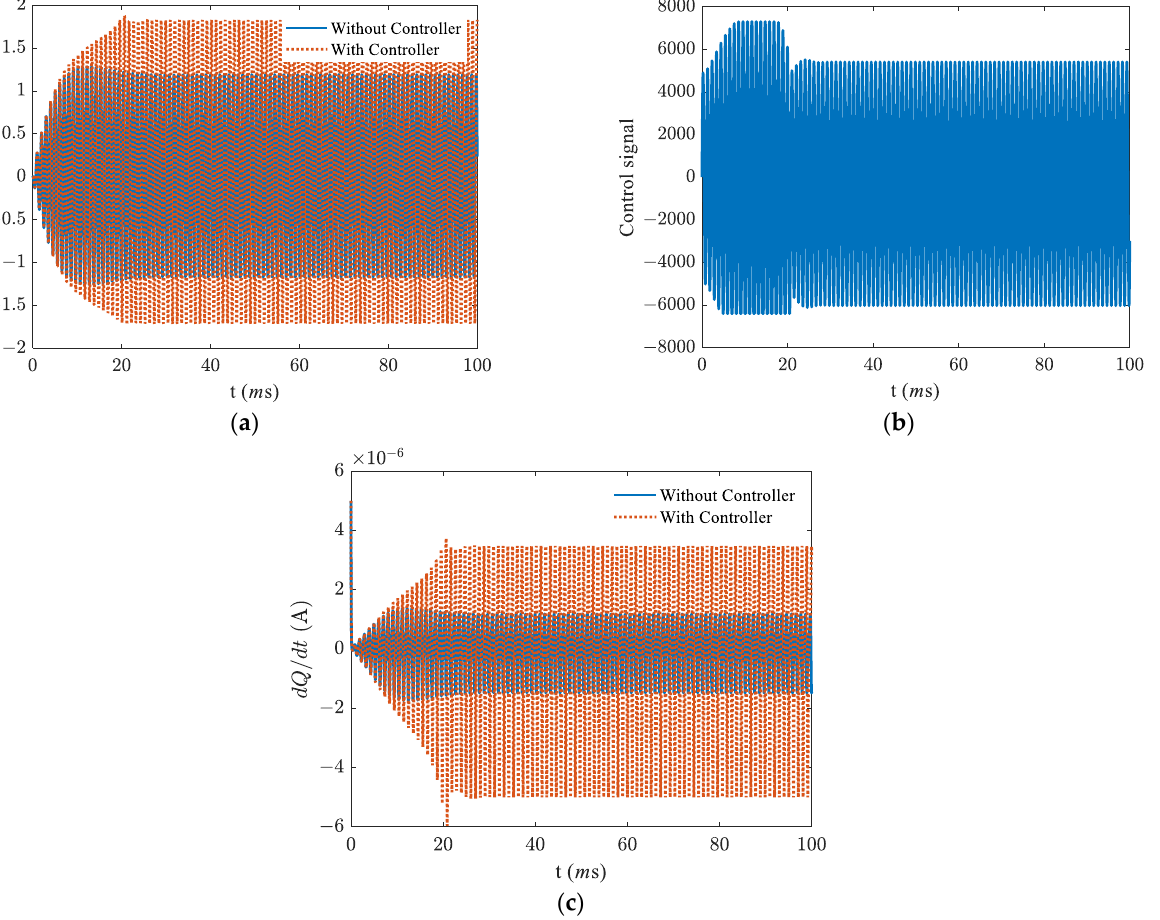
Figure 8. The response in region II, in the presence and absence of the saturation in the PID controller. ( a ) time response, ( b ) feedback signal, and ( c )